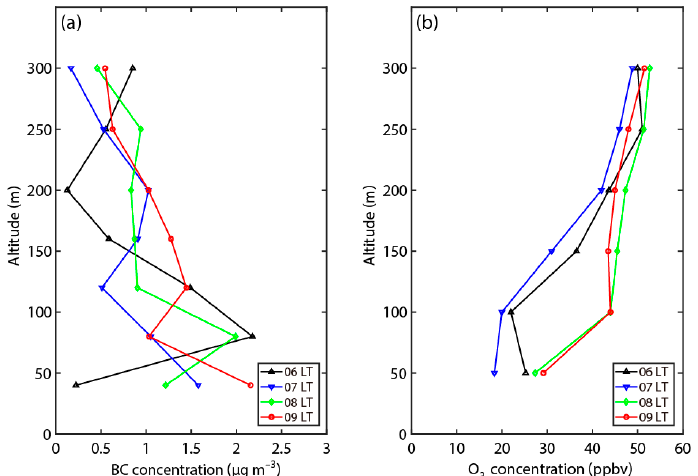
Figure 6. Vertical profiles of ( a ) BC and ( b ) O 3 concentrations observed using the UAV at 06 (black triangle), 07 (blue inverse triangle), 08 (green diamond), and 09 LT (red